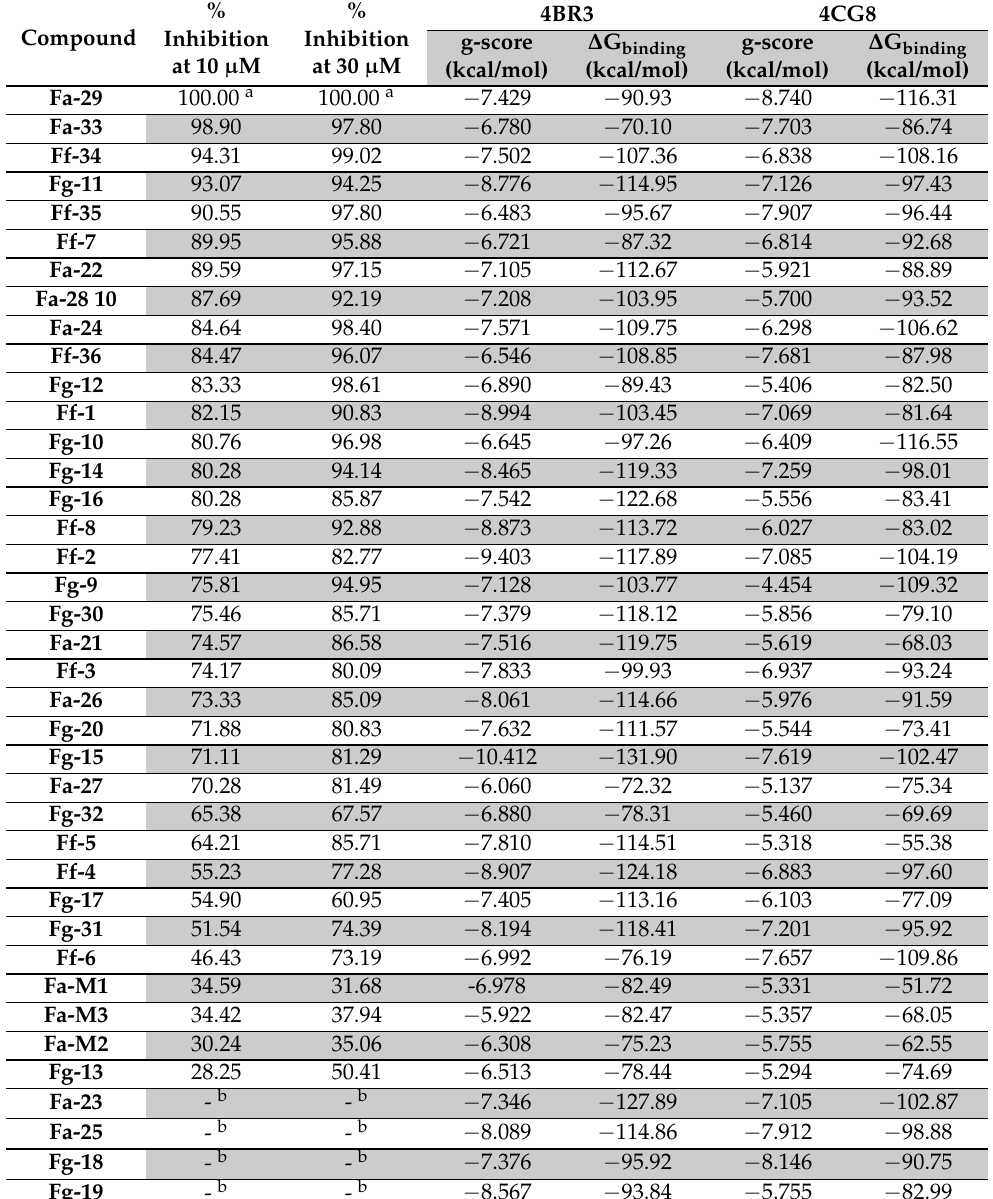
Table 2. Docking scores and calculated ∆ G binding of each